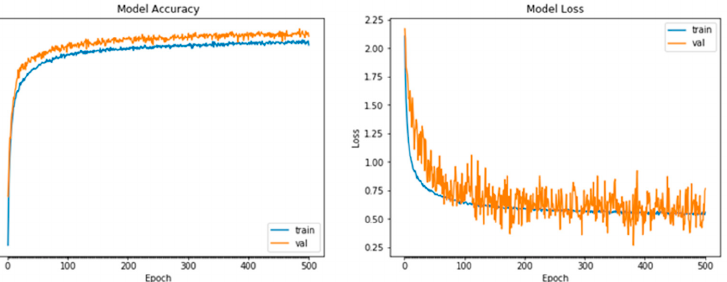
Figure 3. Plot of best-performing NADAM with increasing CNN depth + width on Fashion MNIST.